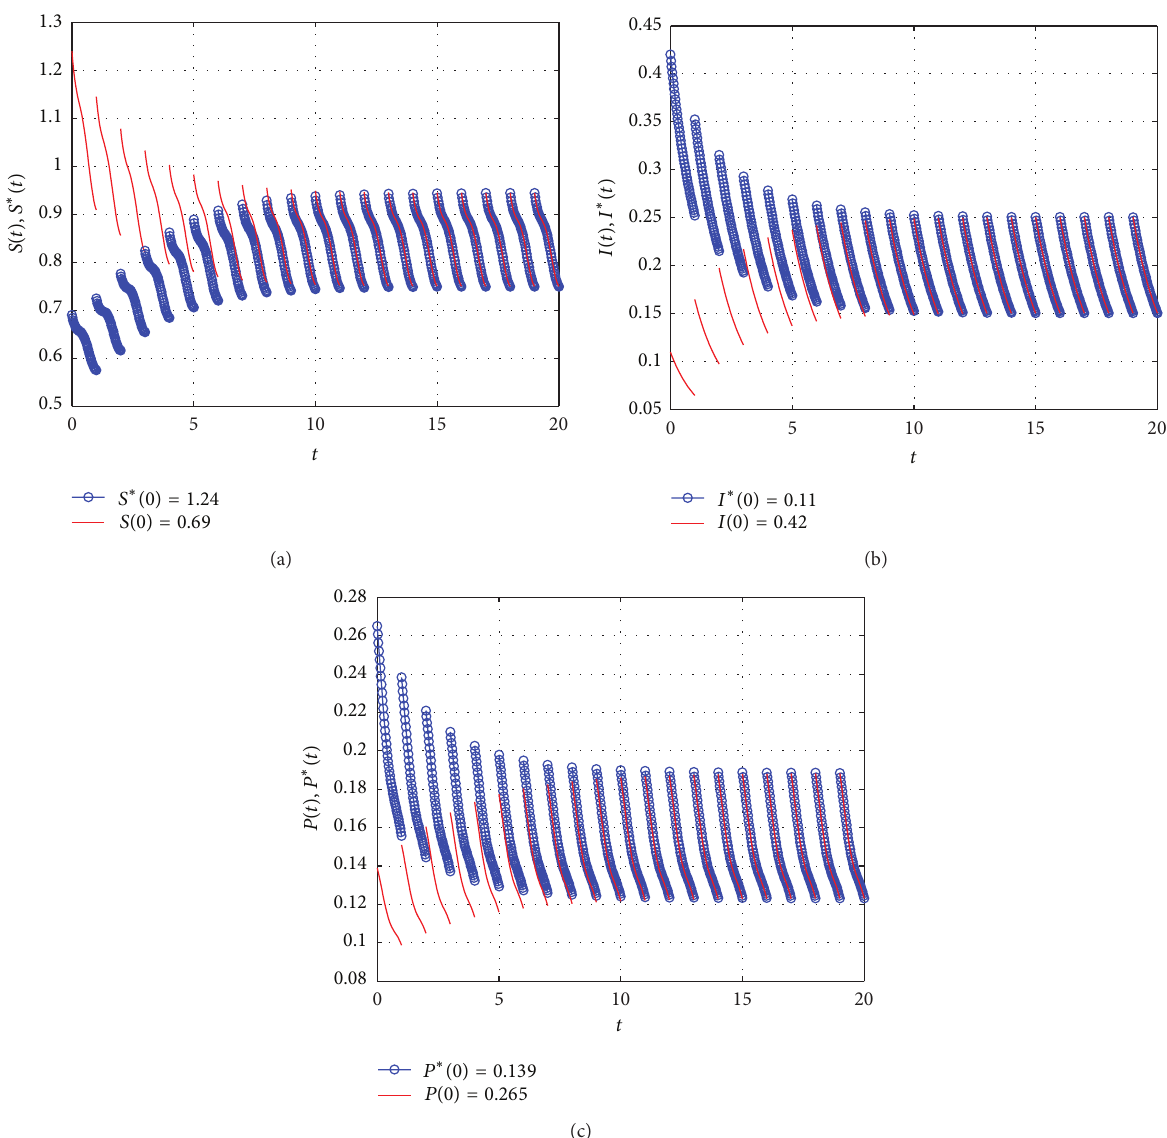
Figure 3: Global attractivity of system (80) with 𝛼 𝑘 = 0.26 , 𝑝 = 0.1 , and 𝛾 𝑘 = 0.53 . (a) Positive solution 𝑆(𝑡) with 𝑆(0) = 0.69 tends to the other positive solution 𝑆 ∗ (𝑡) with 𝑆 ∗ (0) = 1.24 for 𝑡 ∈ [0, 20] . (b) Positive solution 𝐼(𝑡) with 𝐼(0) = 0.42 tends to the other positive solution 𝐼(𝑡) with 𝐼 ∗ (0) = 0.11 for 𝑡 ∈ [0,20] . (c) Positive solution 𝑃(𝑡) with 𝑃(0) = 0.265 tends to the other positive solution 𝑃 ∗ (𝑡) with 𝑃 ∗ (0) = 0.139 for 𝑡 ∈ [0, 20]